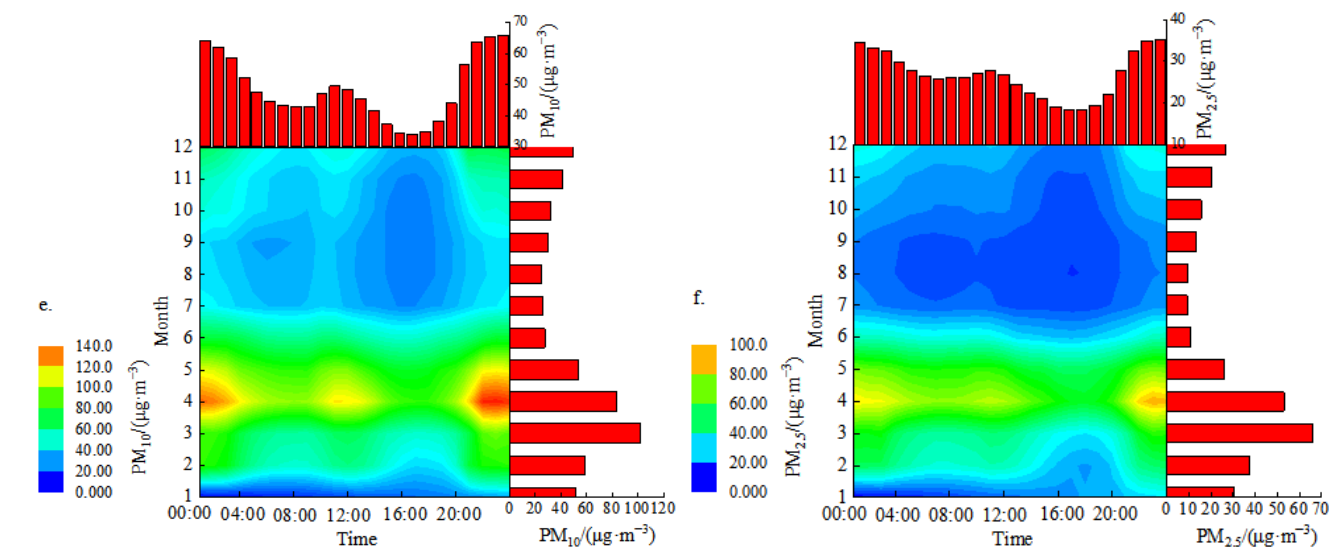
Figure 2. Variation in air pollutants by season and day.